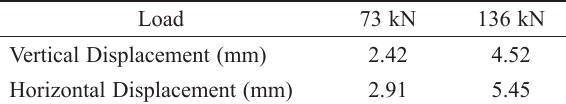
Table 6. Displacement by Load